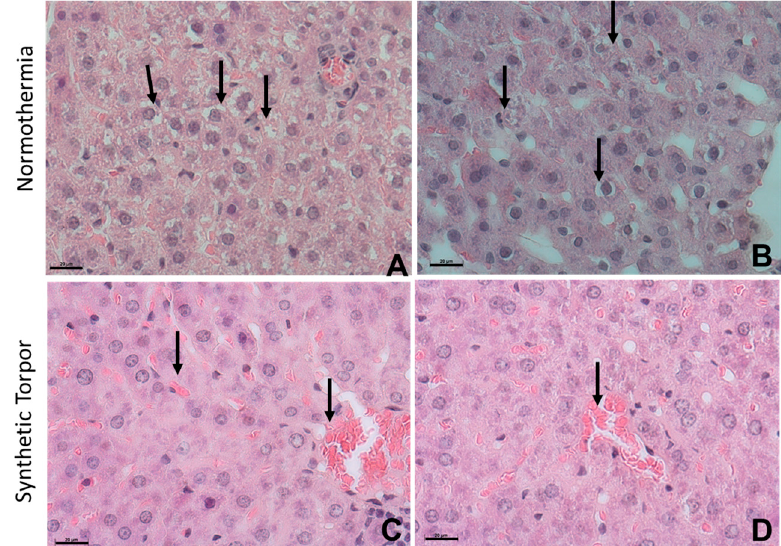
Figure 3. Morphology of the hepatic tissue after hematoxylin-eosin staining in irradiated normothermic liver ( A , B ) and in irradiated liver during synthetic torpor ( C – D ). The effects of irradiation at normothermia are pronounced compared to the effects detected after irradiation in synthetic torpor. Alteration and disorganization in the hepatic parenchyma were observed in A , B , vacuolization and shrunken nuclei with irregular shape and chromatin condensation ( A , B , arrows) were identified in the hepatocytes. The morphology and the organization of hepatic parenchyma irradiated during synthetic torpor ( C , D ) seems comparable to the normal organization of the liver tissue. Hepatocytes show a dense cytoplasm, round nuclei with dispersed chromatin. An abundance of red blood cells is also observable ( C , D arrows). Scale bars = 20 µm.